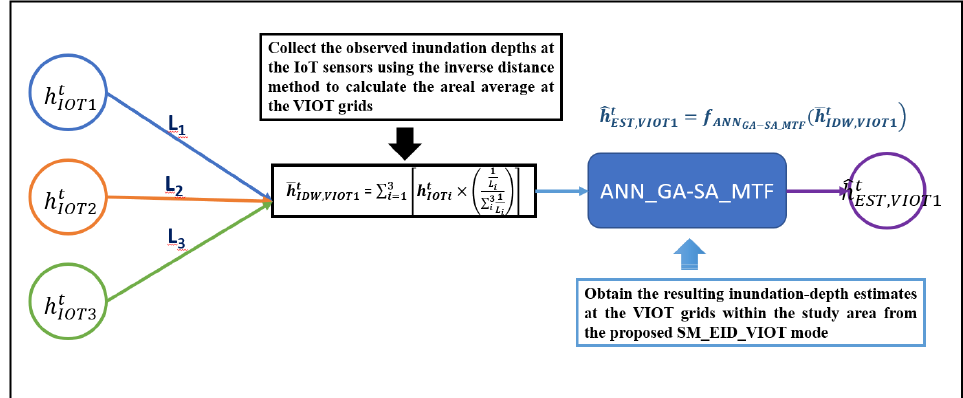
Figure 3. The brief graphical framework for estimating the inundation depths at the VIOT spots via the ANN_GA-SA_MTF model within the SM_EID_VIOT model.